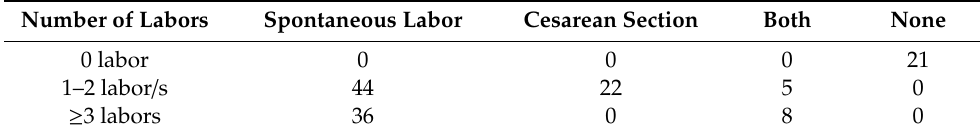
Table 1. Relationship between the number of labors and the method of labor ( p < 0.00001).